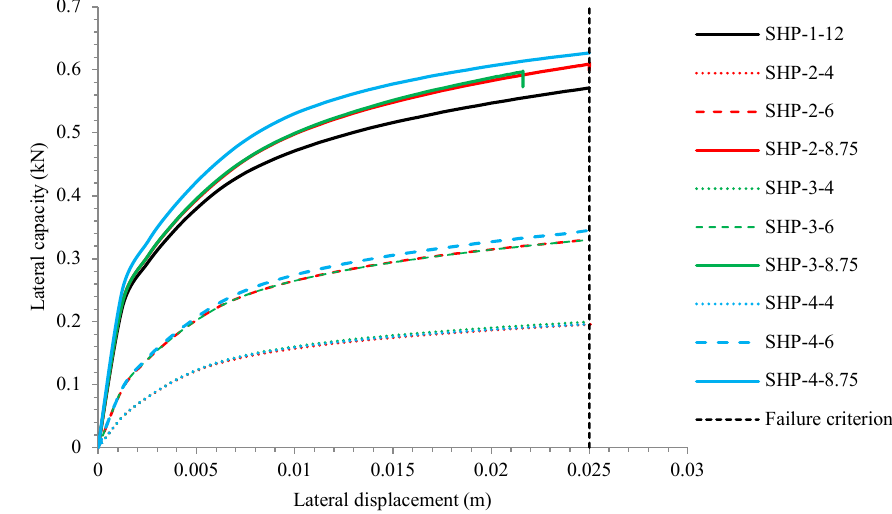
Figure 8. Load–displacement curve for lateral capacity of helical pile.